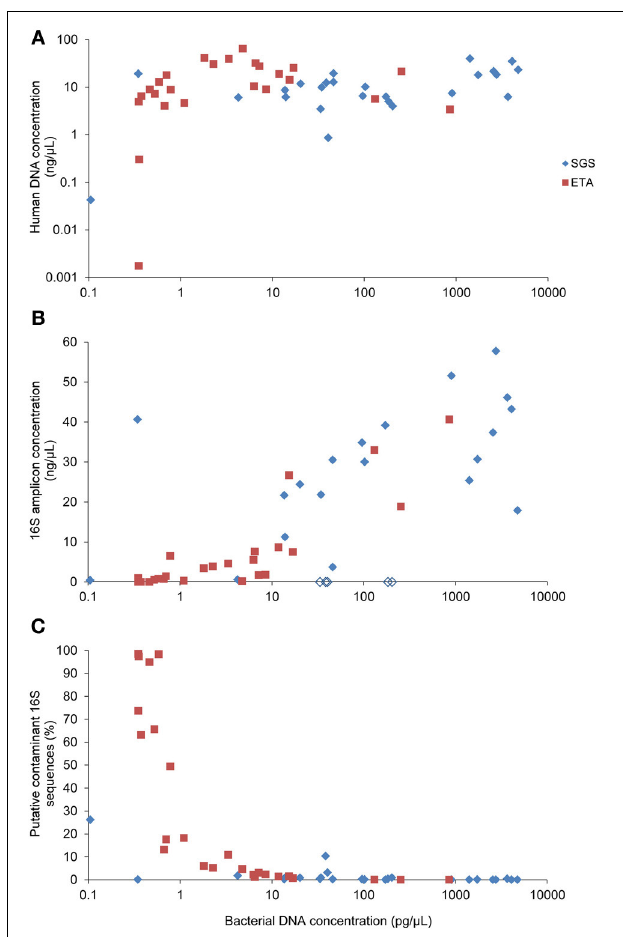
FIGURE 2 | Correlation between bacterial DNA yield and (A) human DNA yield, (B) concentration of the 16S rDNA amplicons or (C) percentage of putative contaminant 16S rDNA sequences. Bacterial and human DNA concentration in purified extracts was determined by qPCR. The yield of the 16S rDNA amplicon concentration was determined using Bioanalyzer. Empty lozenges (in B ) correspond to SGS samples from the subject